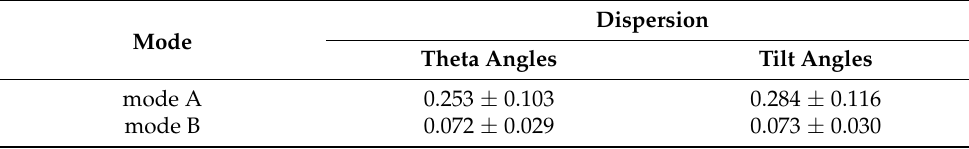
Table 3. Centroid and dispersion of planes intersections.